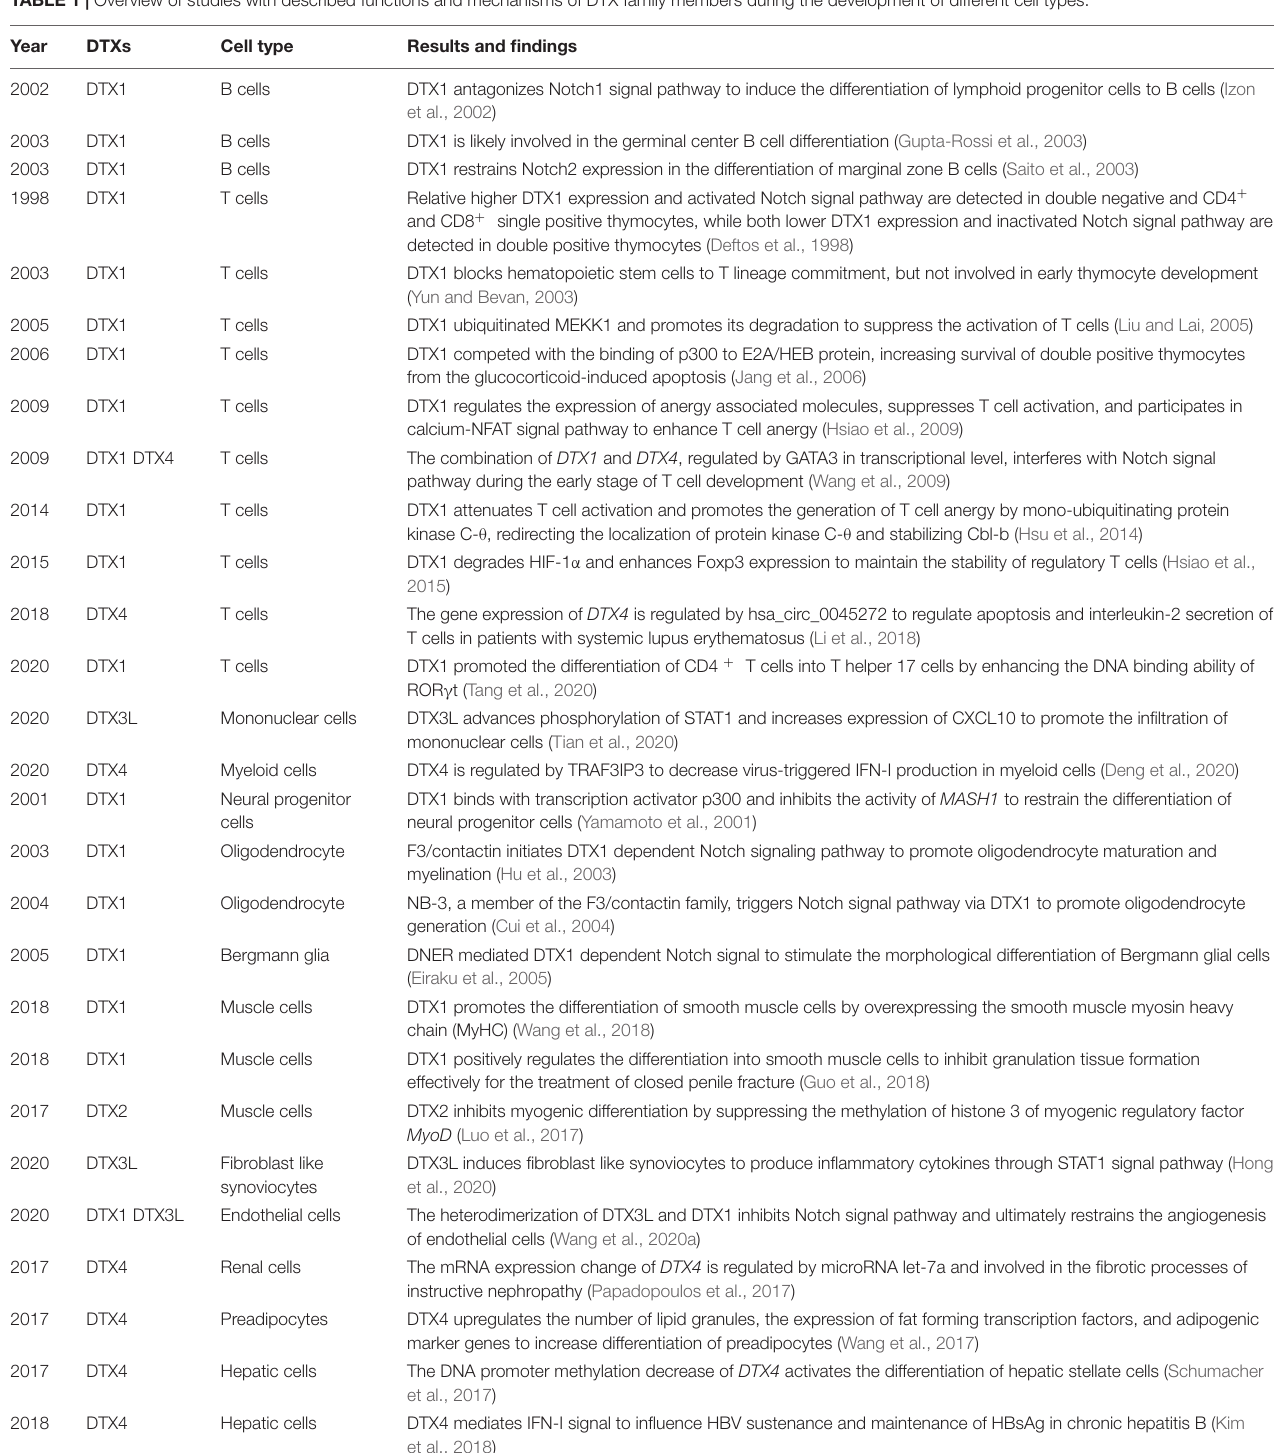
TABLE 1 | Overview of studies with described functions and mechanisms of DTX family members during the development of different cell types. Year DTXs Cell type Results and